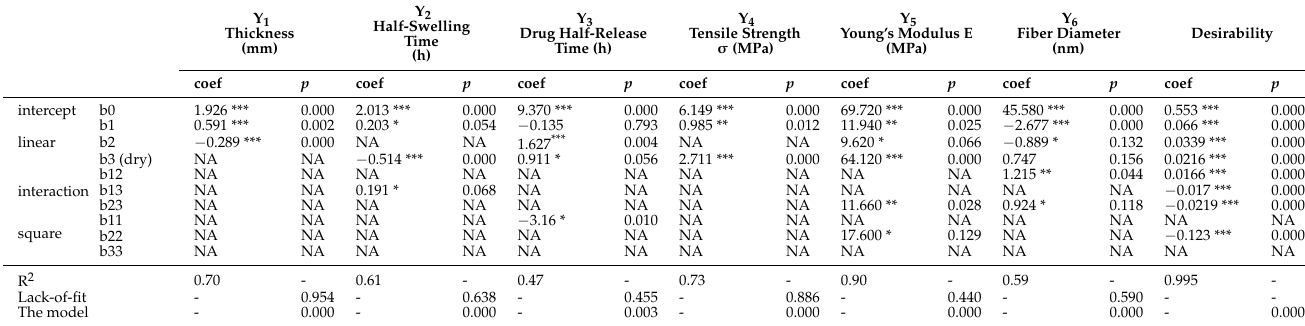
Table 3. Model parameters (coded coefficients), p values, and goodness-of-fit statistics obtained by response surface methodology (RSM) for each of the 6 response variables (Yi).